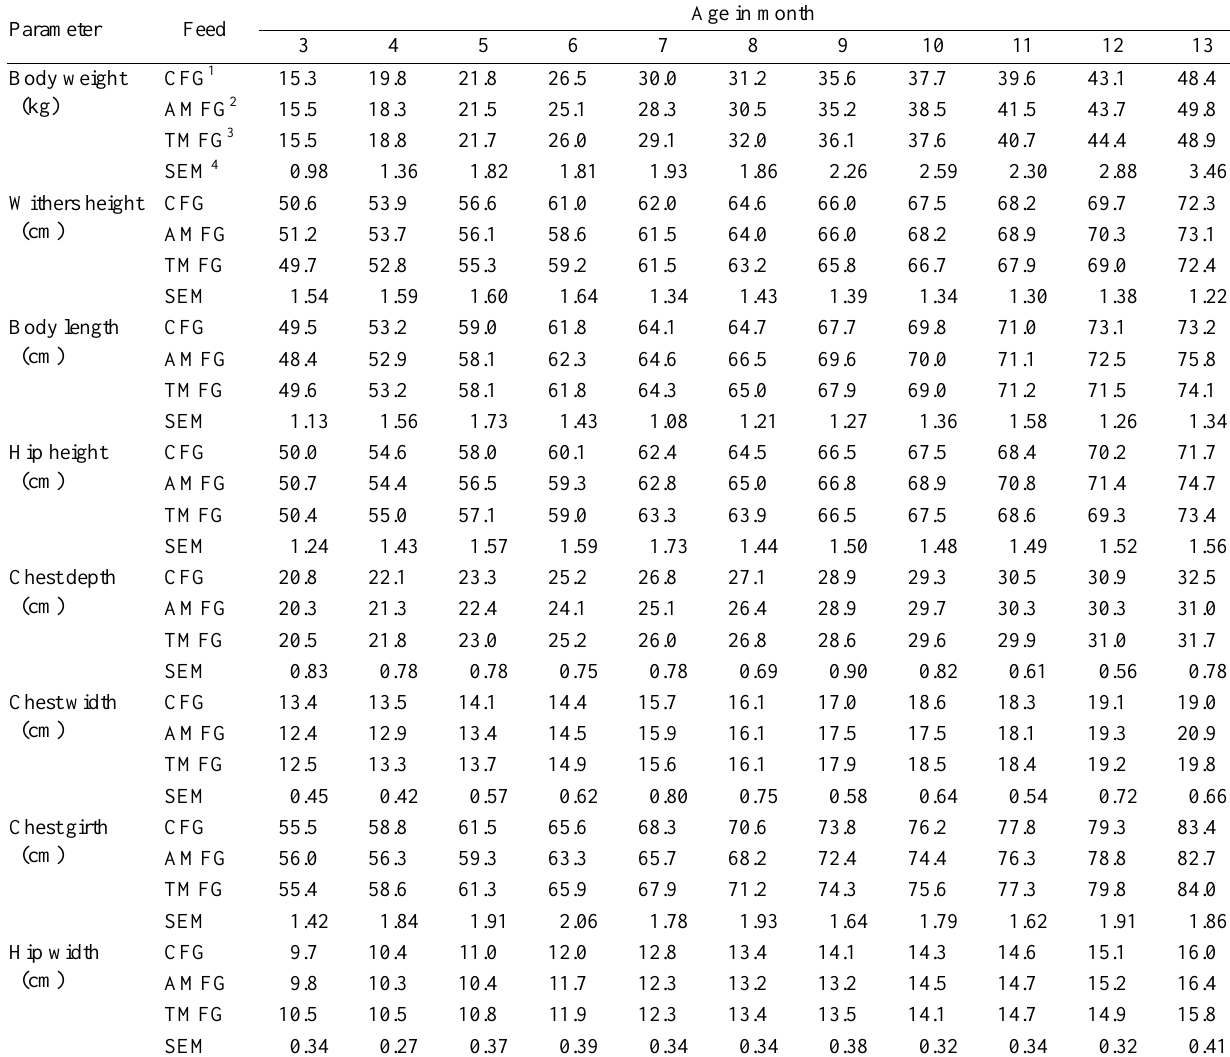
Table 7. Effect of feeding Awamori-pressed lees mixed feed (AMF) and Tofu lees mixed feed (TMF) on the growth of female goats Parameter Feed Body